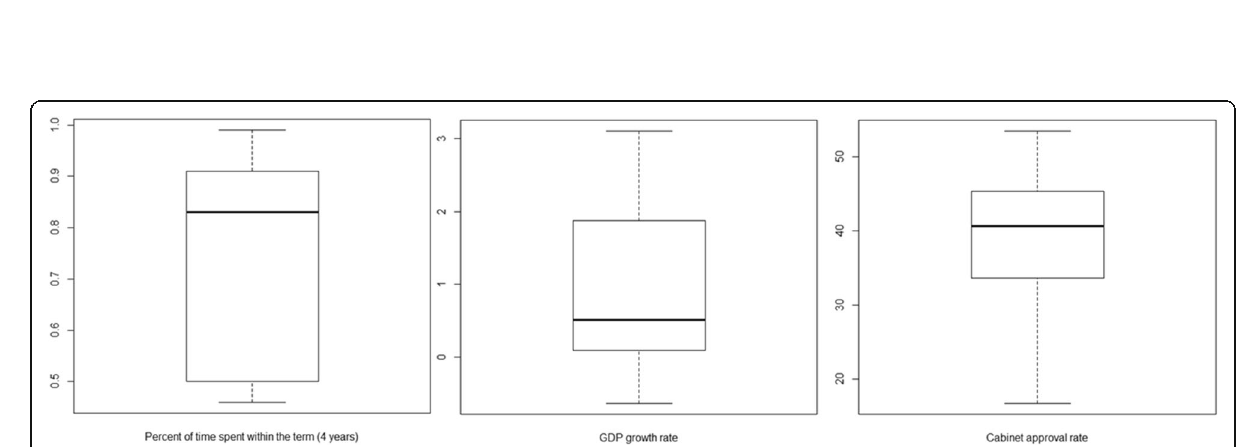
Fig. 14 Boxplot of the “ Non-manipulation ” Group, excluding the 1993